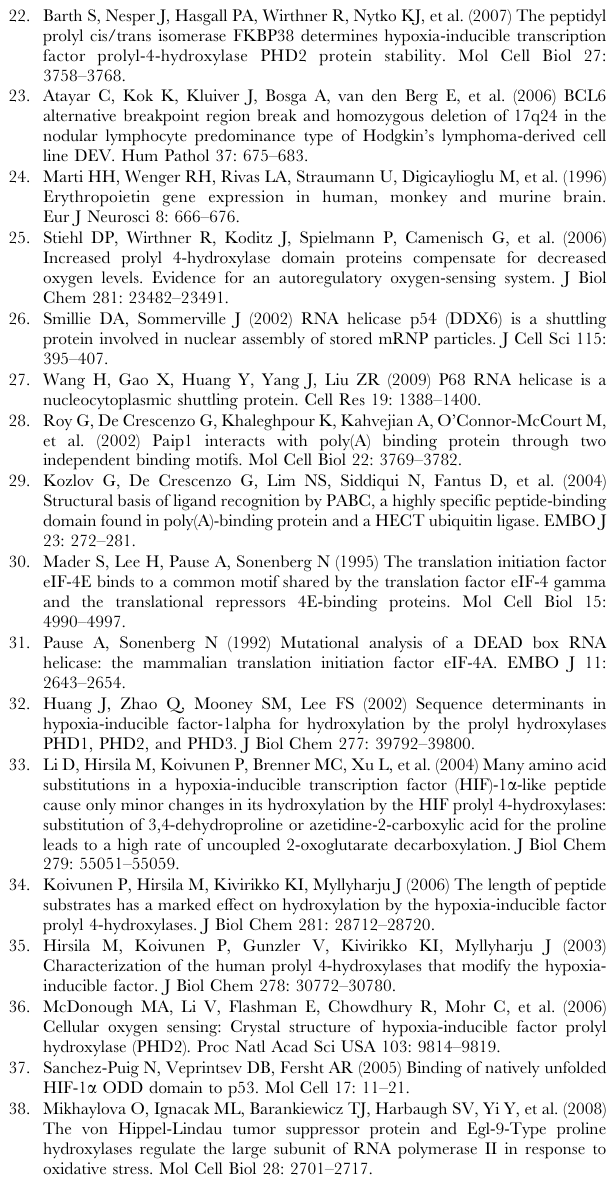
cence and nuclei were stained with Dapi (right panel). Figure S2 Crude HeLa cell lysates were incubated with recombinant GST, the indicated GST-HELZ fragments, GST- HIF-1 a 530–826 as well as GST-Paip2 106–127 and GST pull–down was conducted using glutathione–sepharose beads. Eluates were subjected to SDS–PAGE and immunoblotting. Table S1 Overview of proteins with two conserved LxxLAP motifs. Using the PROSITE pattern search tool [53] the Swiss–Prot database was searched for proteins containing two LxxLAP motifs. Conservation analysis across 33 species was subsequently performed using the MULTIZ